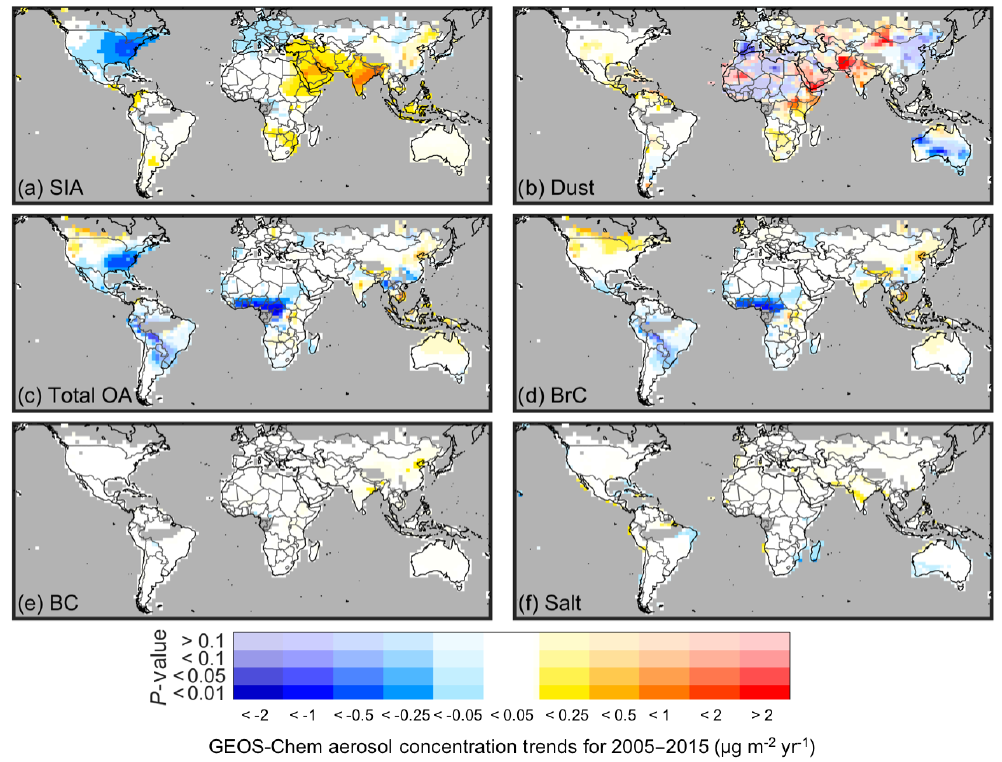
Figure 7. Trend in GEOS-Chem aerosol concentrations for (a) secondary inorganic aerosol (SIA), (b) dust, (c) total organic aerosol (OA), (d) brown carbon (BrC), (e) black carbon (BC), and (f) sea salt. The trends are calculated from the GLS regression of monthly aerosol concentration time series values during 2005–2015. The opacity of the colours indicates the statistical significance of the trend. Grey indicates persistent cloud fraction greater than